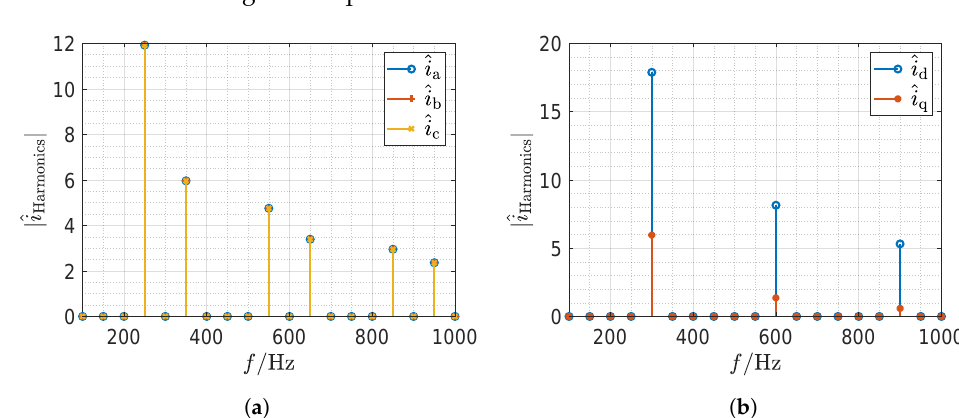
Figure 9. Spectrum of harmonic distortion current i harm . ( a ) Spectrum of i harm in abc domain. ( b ) Spectrum of i harm in dq